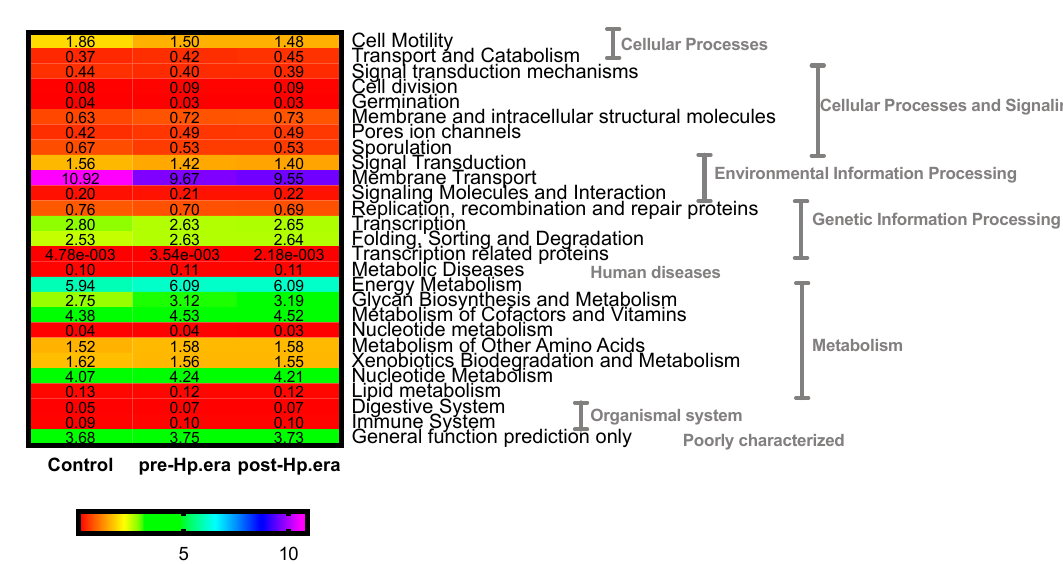
Figure 3. Predicted functional composition of metagenomes based on 16S rRNA gene sequencing data of H. pylori infected patients and after the eradication therapy and healthy control subjects. Heatmap shows the differentially abundant Kyoto Encyclopedia of Genes and Genomes (KEGG) pathways identified in the three study groups (FDR-ajusted-P ≤ 0.05).